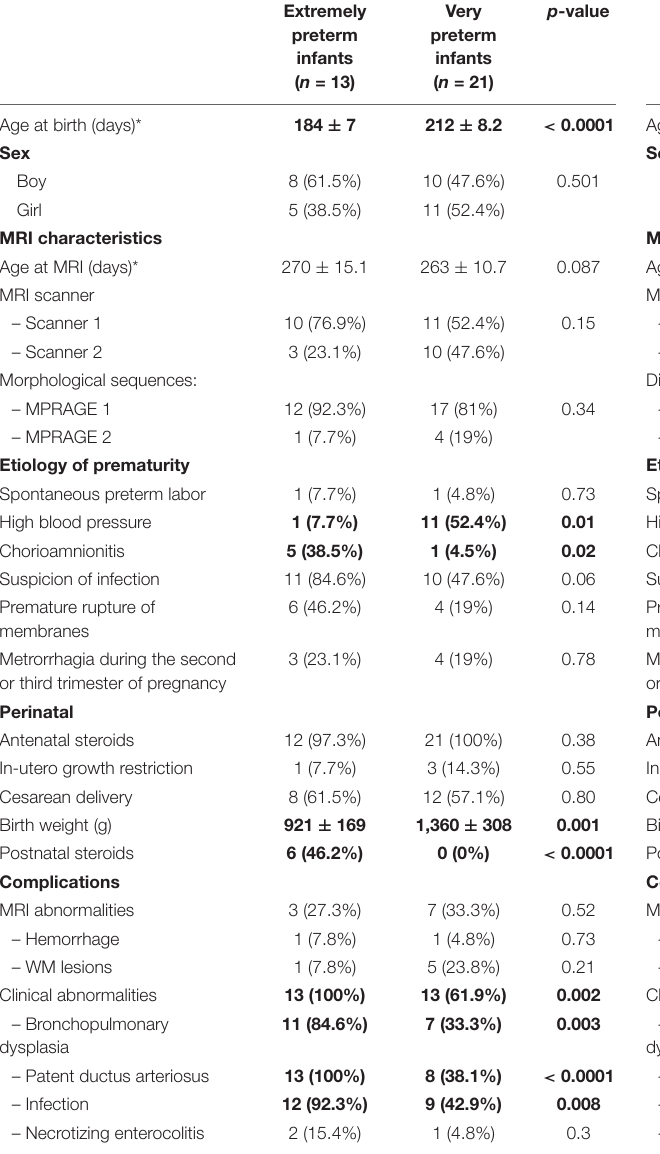
TABLE 2 | Subject characteristics for morphologic analysis. TABLE 3 | Subject characteristics for diffusion analysis.